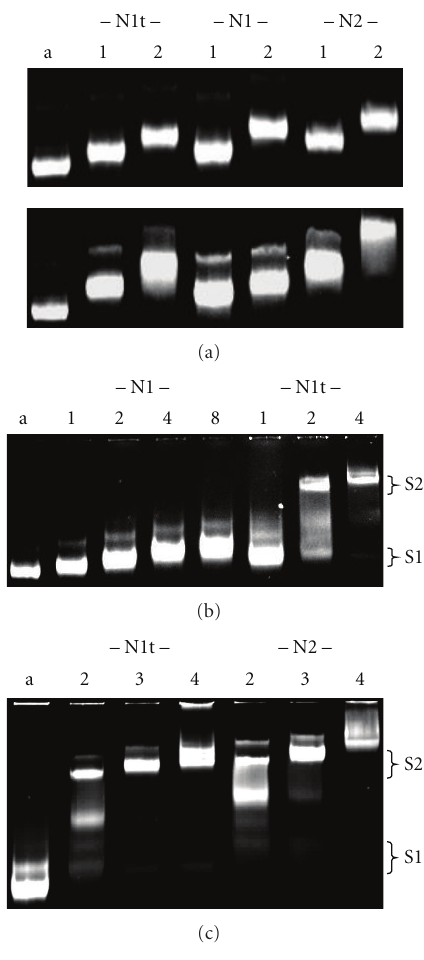
Figure 3: S2 formation is divalent metal dependent and requires HMGN elements outside of the NBD. EMSA gel labels indicate HMGN identity (N1t, HMGN1t; N1, HMGN1; N2, HMGN2; a, 12-array alone; n, NCP alone), and numbers designate HMGN: nucleosome molar stoichiometry. (a) HMGN binding to 12-array at near physiological ionic strength with 1mM Ca 2+ . (b) Binding of HMGN proteins and NBD peptides to NCP-601 at near physiological ionic strength with 1mM Mg 2+ . (c) Binding of HMGN NBD peptides to 12-array at low ionic strength (top), near physiological ionic strength (middle), and near physiological ionic strength with 1mM Mg 2+